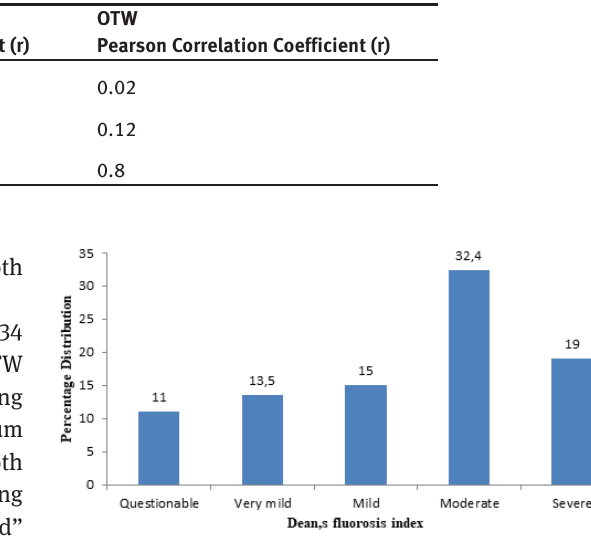
, FT and TSH with Water Fluoride at RM and OTW. 4 3